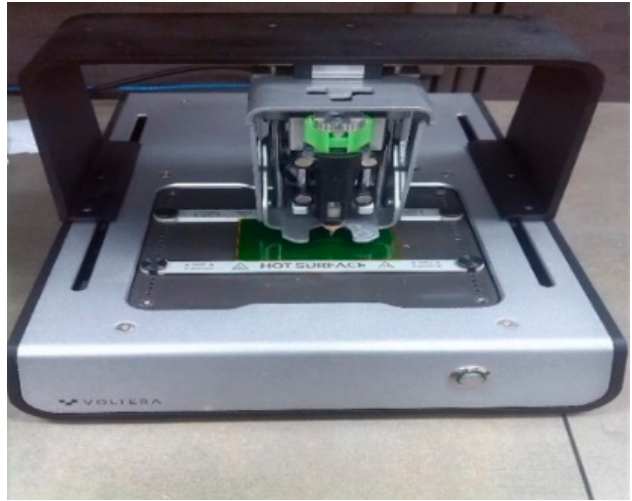
Figure 1. V-one from Voltera was used for fabrication.